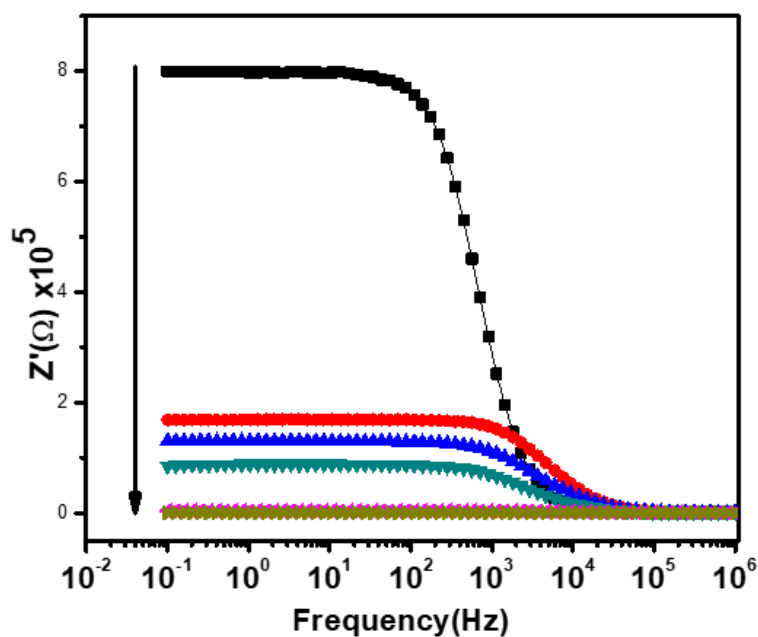
Figure 8. The frequency-dependent real part impedance at various temperatures. Black, red, blue, green, pink, and brown represent the measurements at 25, 100, 150, 200, 250, and 300 °C, respec- tively.